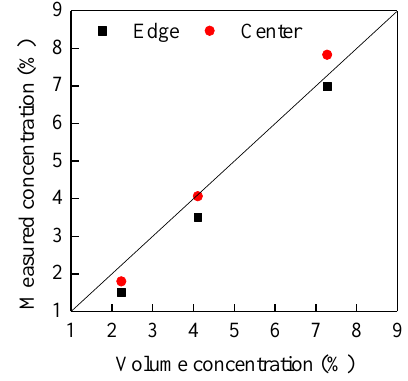
Figure 11. Measured volume concentration.